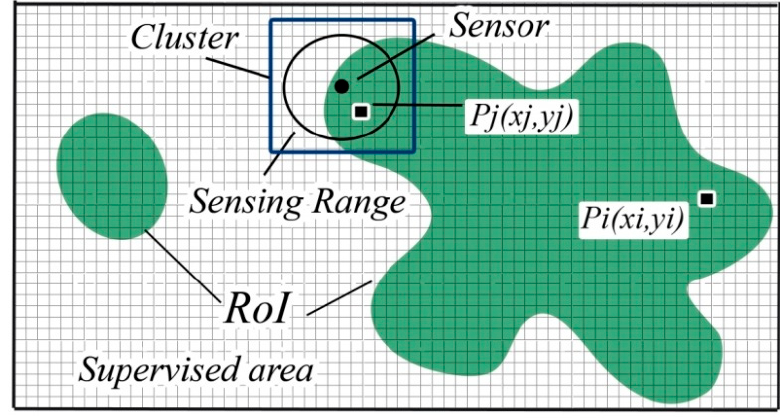
Figure 5. Description of the cluster in the supervised area.